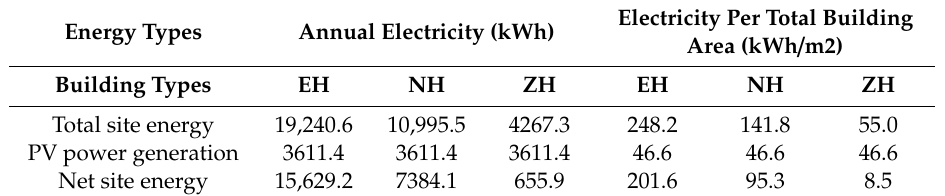
Table 12. Annual electricity consumption and PV power generation.